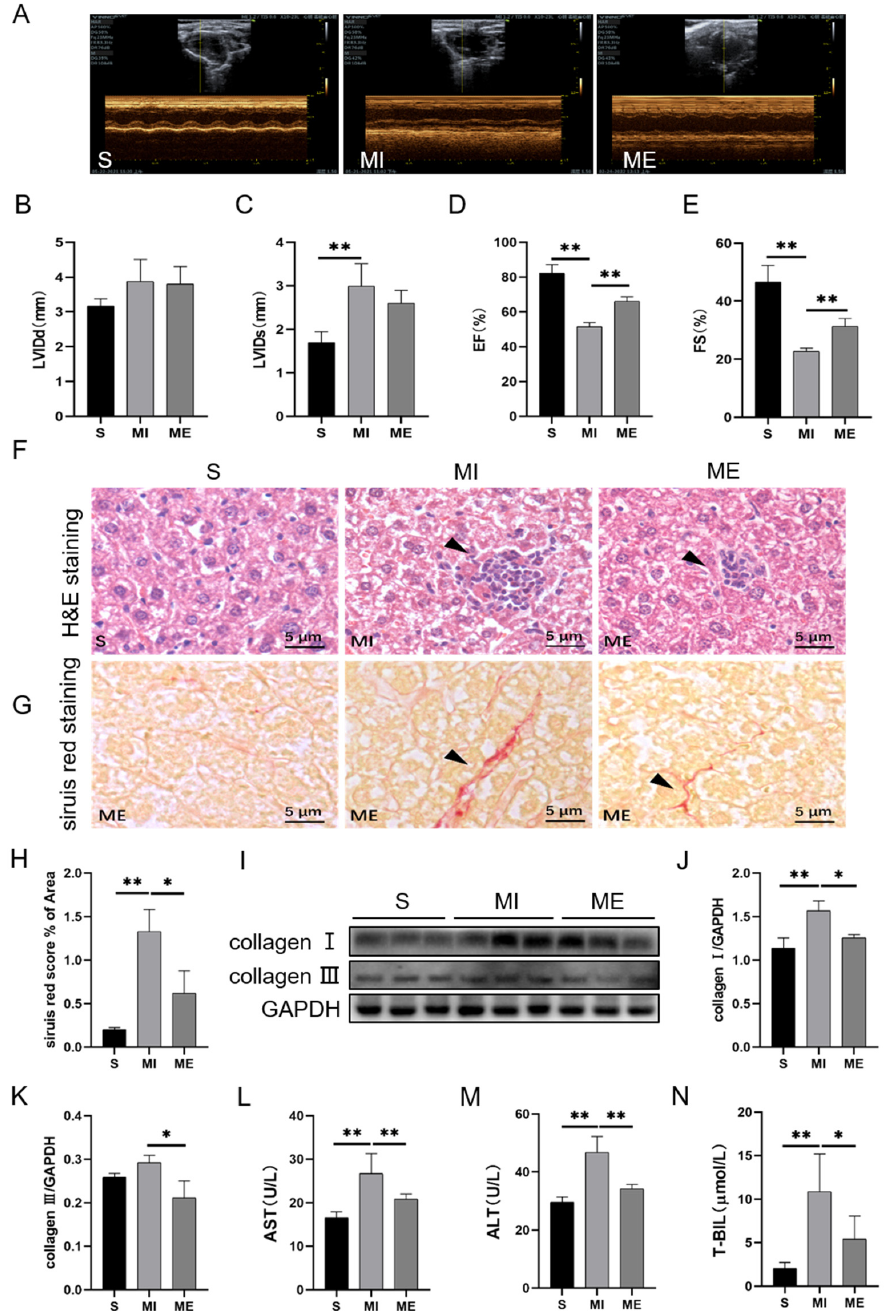
Figure 1. Effects of AE on the structure and function of the liver in mice with MI. ( A – E ), results of echocardiography; ( F ), H&E staining of liver tissue, the arrow indicates the area of inflammatory cell infiltration. ( G , H ), sirius red staining and analysis of liver tissue and collagen fibers (red), the arrow of Figure ( G ) indicates the area of collagen fiber deposition. ( I – K ), the expressions of hepatic collagen I and collagen III. ( L – N ), the levels of AST, AST, and T-BIL in serum. Scale bar: 5 µ m. Data are expressed as mean ± SEM, n = 6. * p < 0.05, ** p < 0.01 by one-way ANOVA. S: sham group; MI: myocardial infarction group; ME: MI with AE